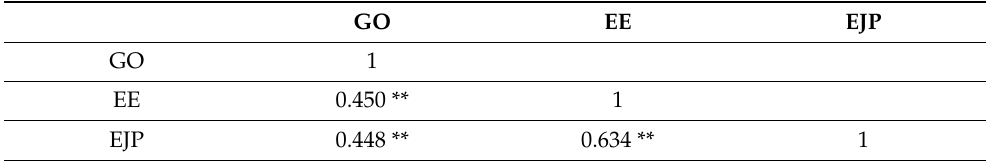
Table 2. Results of Correlation. GO EE EJP GO 1 EE 0.450 **